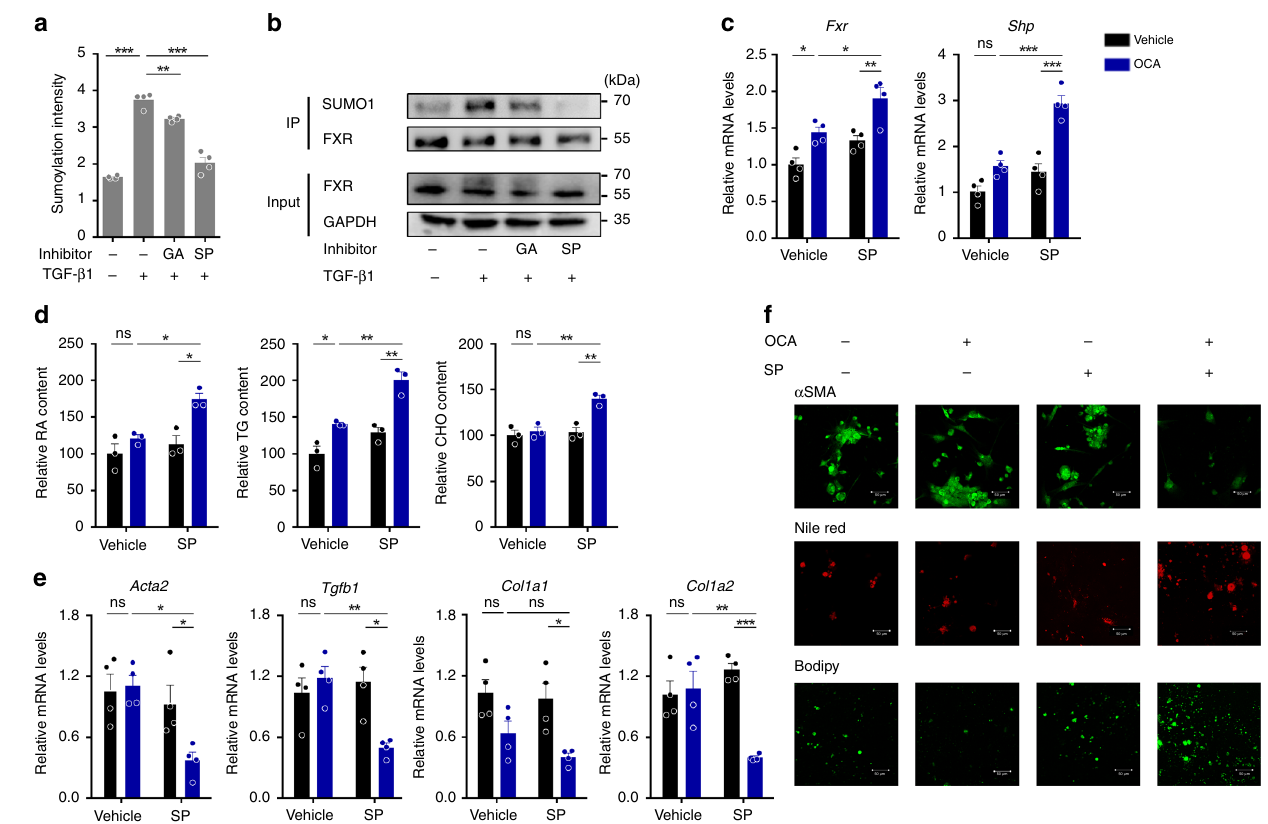
Fig. 5 SUMOylation inhibition restores FXR transactivity and inhibits HSC activation. a , b SP and GA signi fi cantly inhibit FXR SUMOylation in activated HSCs by Protein SUMOylation Assay Ultra Kit ( n = 4 biologically independent samples) a and Co-IP assay (representative of n = 3 biologically independent samples) b . c SP treatment restored the transcriptional activity of FXR. Activated HSCs were treated with OCA in the presence or absence of SP. Fxr and Shp mRNA levels ( n = 4 biologically independent samples). d – f SP treatment restored the bene fi ts of OCA in precluding HSC activation. Activated HSCs were treated with OCA in the presence or absence of SP. Lipid quantitation analysis ( n = 3 biologically independent samples) d , pro- fi brotic gene mRNA levels ( n = 4 biologically independent samples) e , and α SMA, Bodipy, and Nile red staining of HSCs (representative of n = 3 biologically independent samples. Scale bar, 50 μ m). f Results are mean ± SEM, * P < 0.05, ** P < 0.01, *** P < 0.001, and ns, statistically not signi fi cant, as assessed with